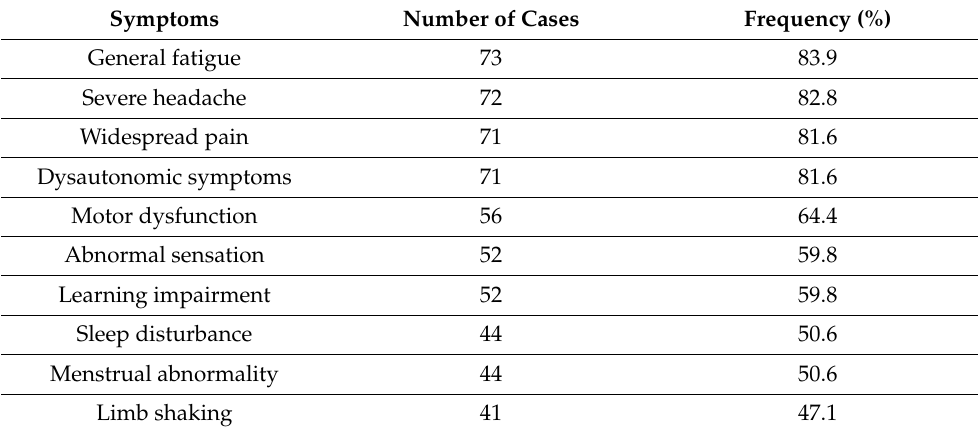
Table 1. Frequency of symptoms and signs in the 87 patients